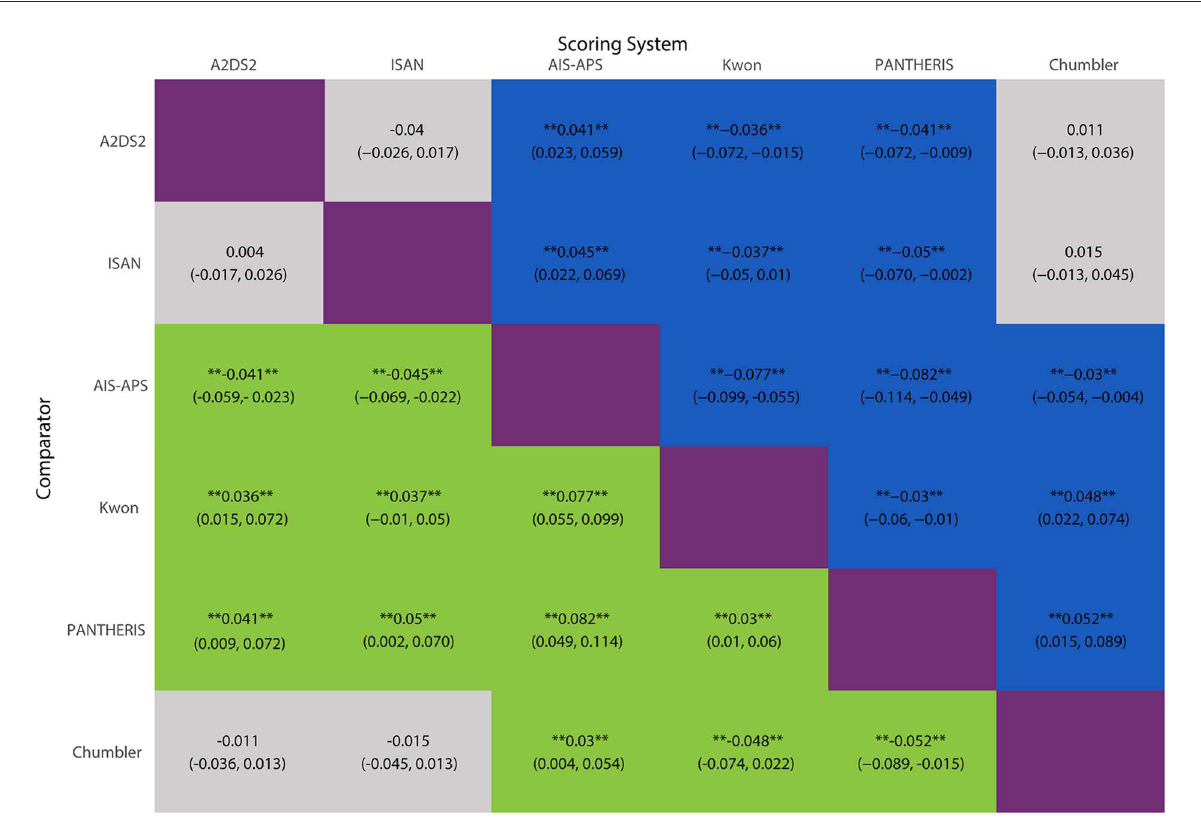
FIGURE6 MD with 95% CIs of AUC of six risk scores for SAP. The values in each cell represent the relative effect of the risk score on the top, compared to the risk score on the left. **Indicates statistical